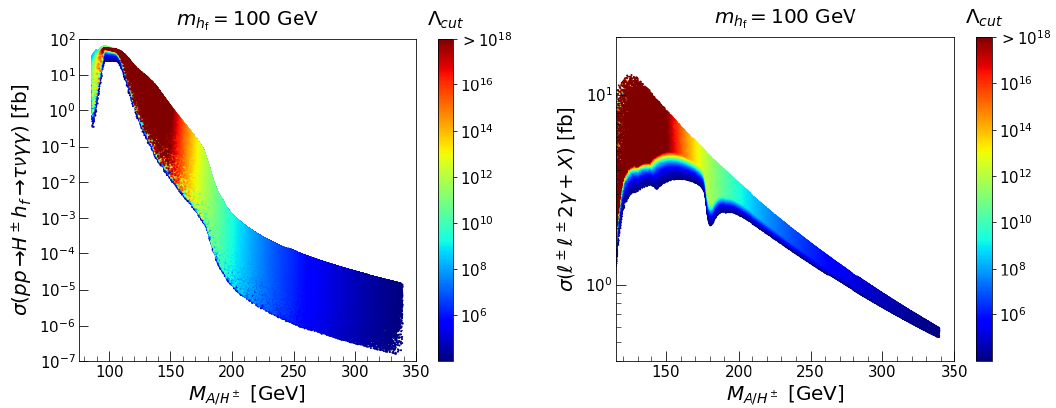
Figure 11 . The total cross sections of pp → τ ± νγγ (left panel) and pp → ‘ ± ‘ ± γγ + X (right panel) at the 14 TeV LHC about M for m h = 100 GeV . The color code denotes the cutoff scale Λ cut A/H ± f